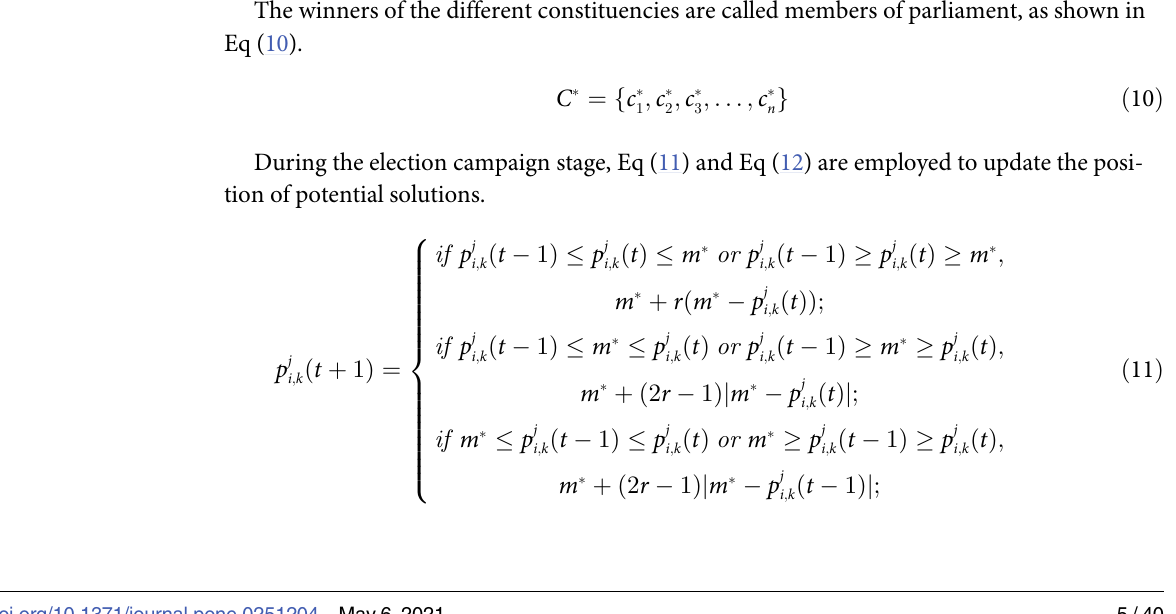
in constituency C3 is exchanged with p 1 in 1 2